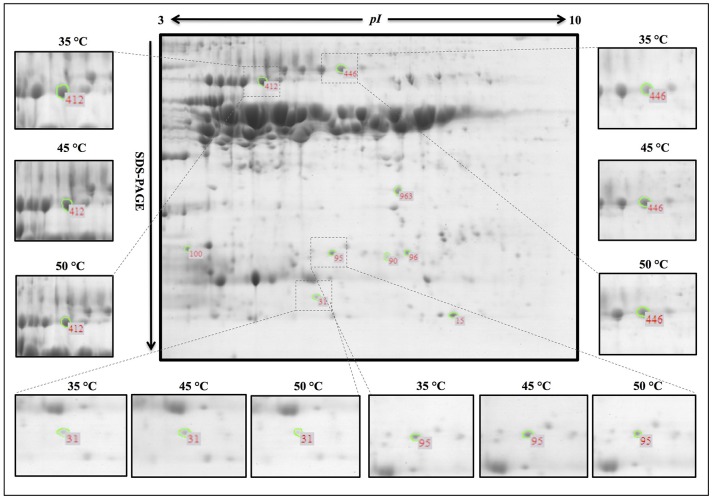
Representative 2-DE pattern of the oat seed proteome under heat stress. Spot numbers indicate the protein spots analyzed by Image Master 2D Platinum 7.0 software. Zoomed images show the main differentially expressed protein spots in deteriorated oat seeds. Spot 446, up-regulation in oat seeds with 16% MC after heat-stress treatment; spots 31, 95, 412, down-regulation in oat seeds with 10 and 16% MC after heat-stress treatment. The three biological replicates of the 2-DE gels are shown in Supplementary Figure 1.